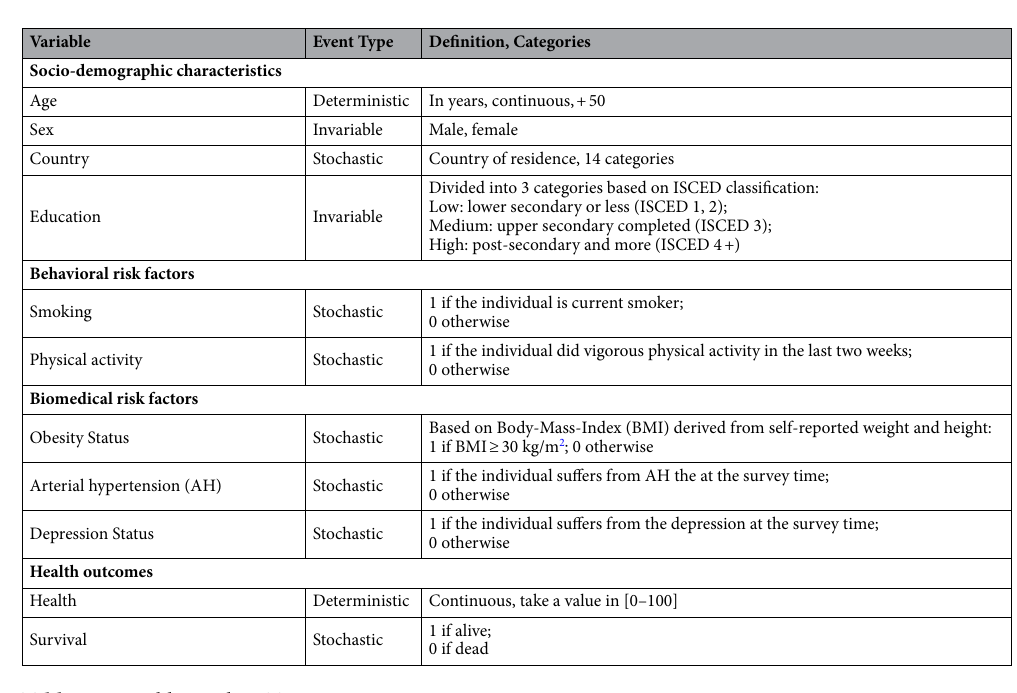
Table 2. Variables in the